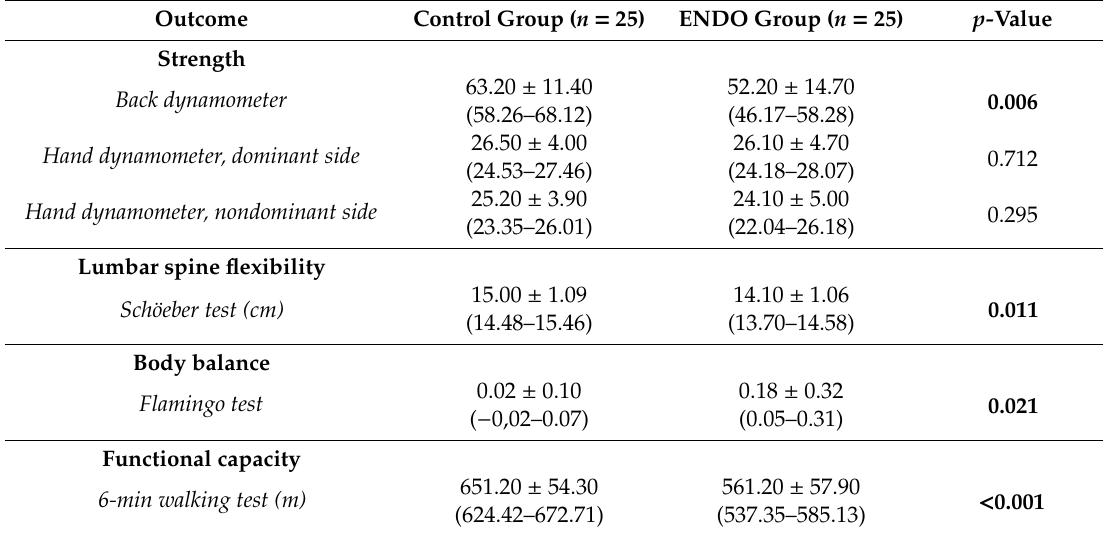
Table 2. Health-related fitness in women with and without endometriosis.